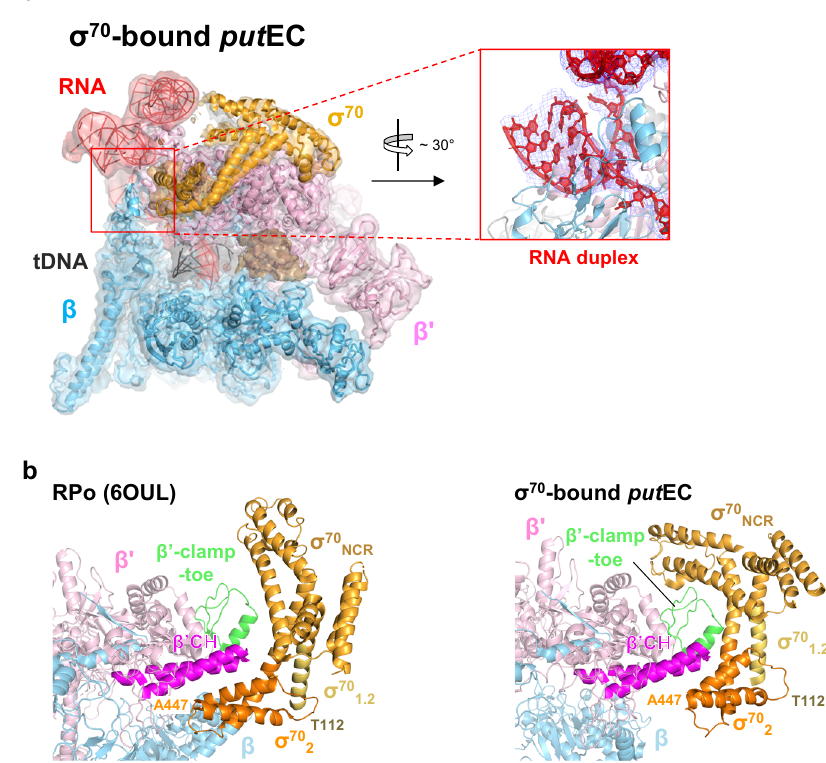
b Comparison of the σ 70 -RNAP binding between the RPo and the σ 70 -bound put EC. Nucleicacidswerenotdrawnforclarity. β ‘ clamphelices( β ‘ CH),themainstructural element interacting with σ 70 in the RPo, are highlighted in magenta color. σ 70 is colored by domains as labeled. β ‘ -clamp-toe, which interacts with σ NCR in the σ 70 - bound put EC, is colored